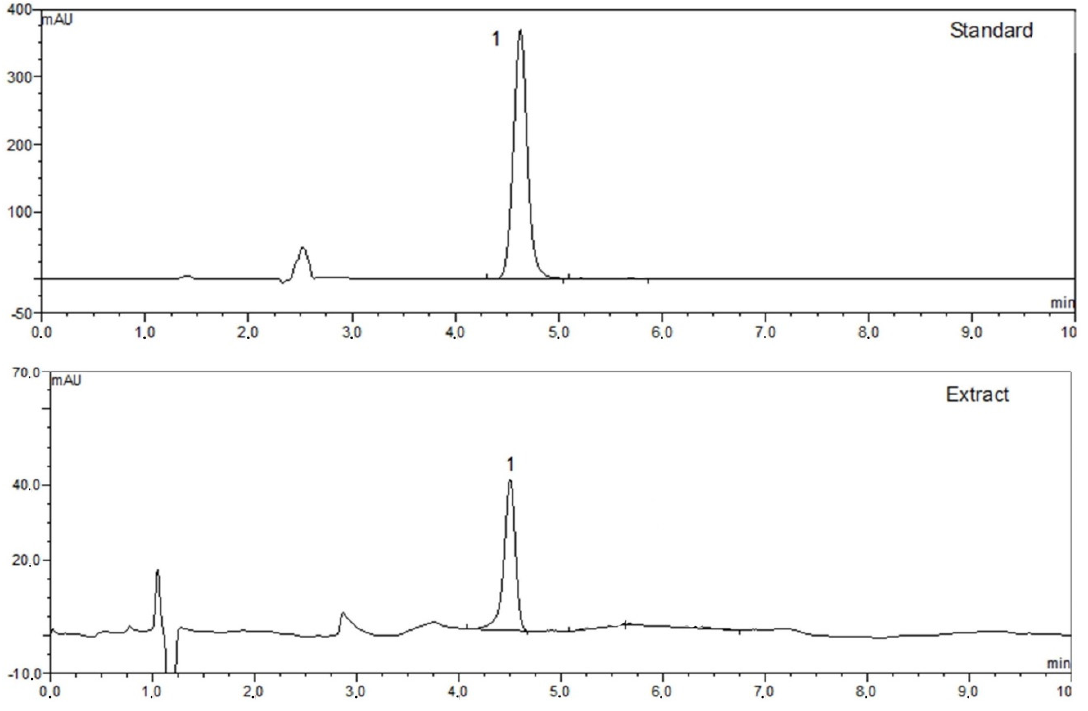
Figure 5. HPLC-chromatogram of SOPSS transgenic hairy root extract sample. 1 = betulinic